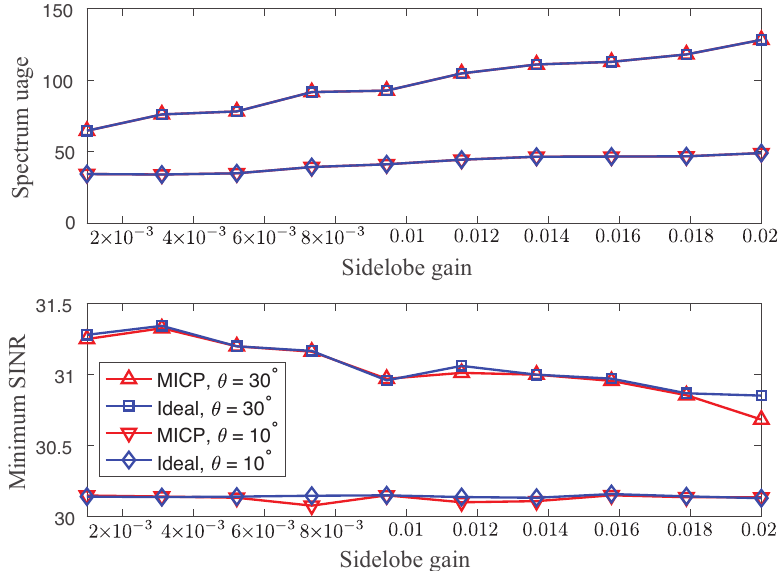
Figure 5. Expected values of spectrum usage ( top ) and minimum SINR ( bottom ) using the ideal solutions and heuristic solutions of mixed-integer convex problem (MICP) as a function of different sidelobe gains ( g 2 = 0.001, . . ., 0.02) with θ = 10 ◦ , 30 ◦